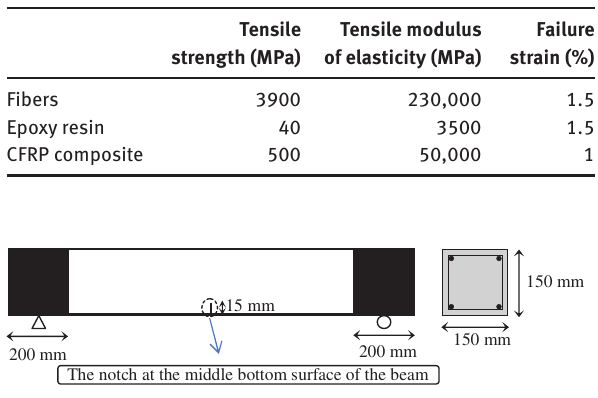
Table 1: Mechanical properties of carbon fiber, epoxy resin, and CFRP composite.